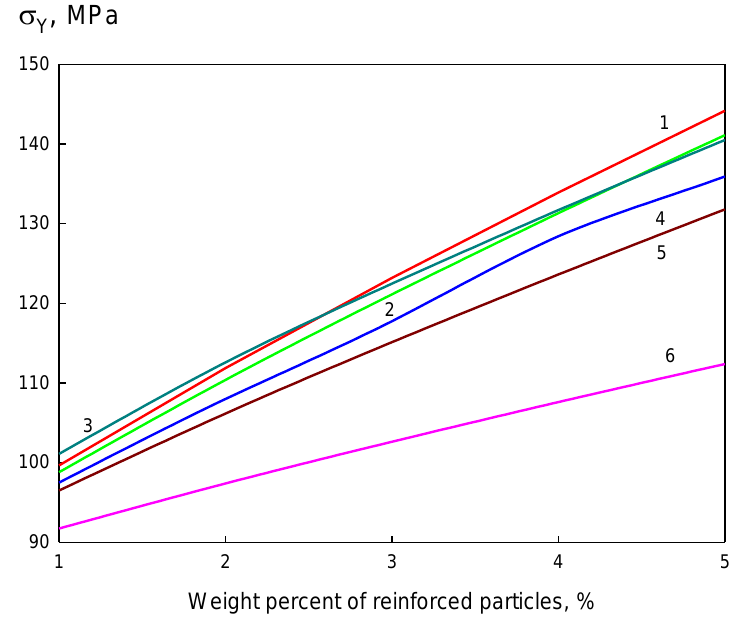
Figure 13. Dependence of the yield stress on the mass fraction of the second phase in alloys strengthened by particles of different materials with temperature difference 100 T  = K: 1 — SiC; ened by particles of different materials with temperature difference ∆ T = 100 K: 1—SiC; 2 —B 4 C; 2 — B 4 C; 3 — ScF 3 ; 4 — TiB 2 ; 5 — Al 2 O 3 ; 6 — TiO 2 . 3—ScF 3 ; 4—TiB 2 ; 5—Al 2 O 3 ; 6—TiO 2